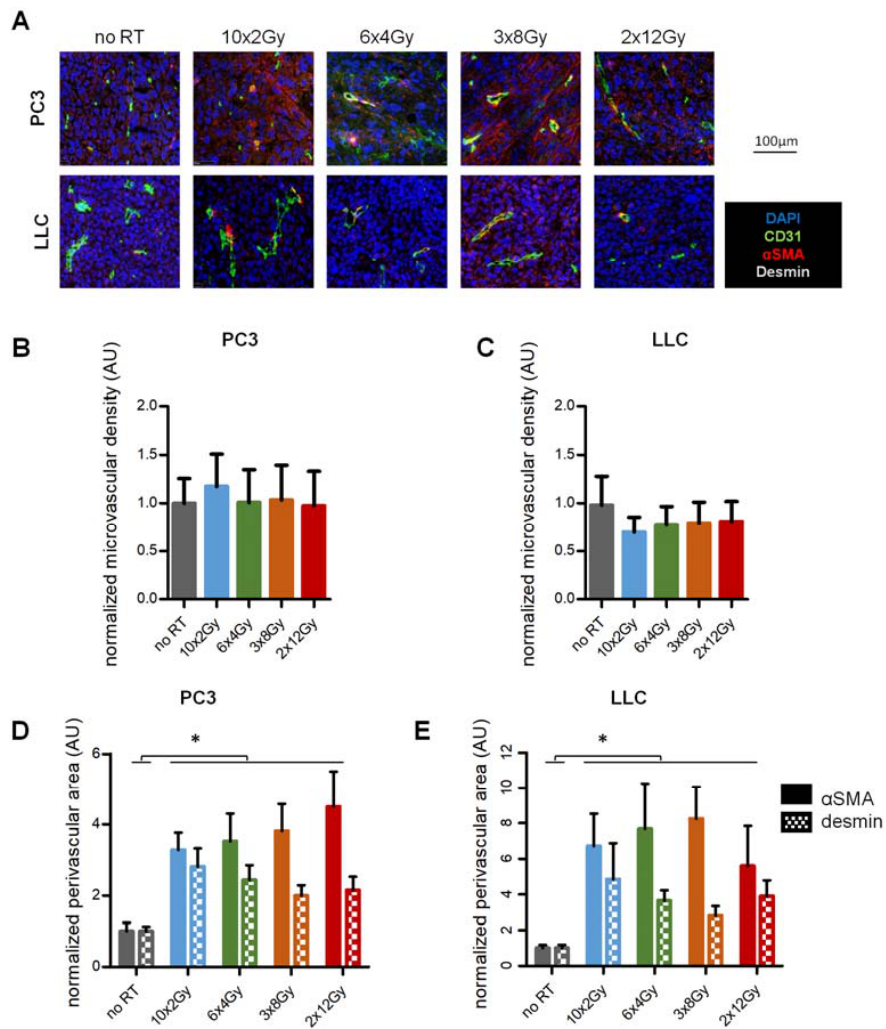
Figure 2. Tumor vascular phenotype in response to RT fractionation schedule. ( A ) Immunohistological staining for pericyte coverage ( α SMA, desmin) around tumor vessels (CD31) two weeks after RT initiation in PC3 and LLC tumors. ( B , C ) Quantification of vessel density in PC3 ( B ) and LLC ( C ) tumors at day 15. ( D , E ) Quantification of vascular mural coverage ( α SMA: plain, desmin: squared) in PC3 ( D ) and LLC ( E ) tumors at day 15. Images and analysis represent two independent experiments with a total ≥ 18 tumors per point. * indicates p < 0.05.